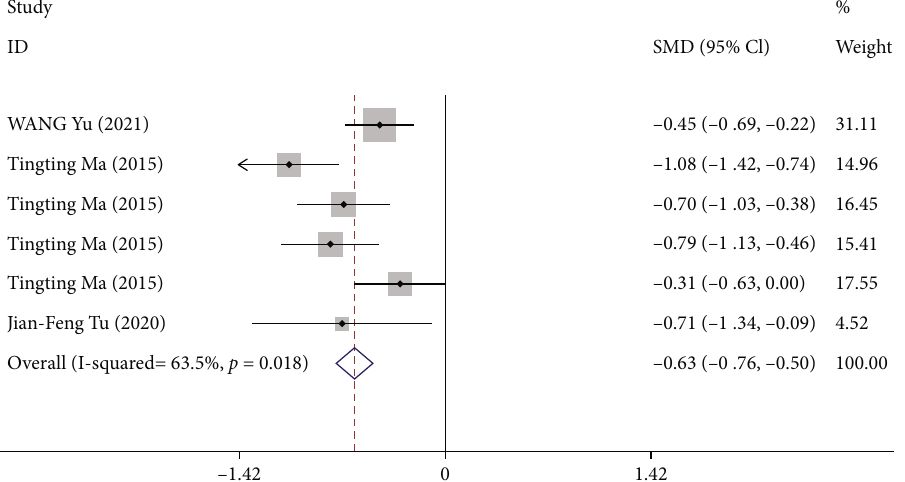
Figure 8: Forest plot of comparison. Acupuncture vs. sham acupuncture. Outcome: change in postprandial fullness score from baseline to week